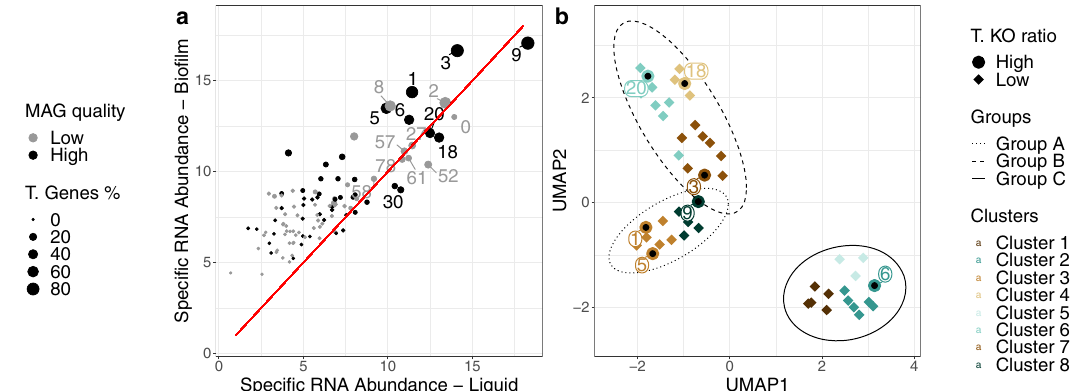
Fig. 1 Relationship of MAGs in bio fi lm and liquid according to speci fi c RNA abundance and their functional grouping. a Relationship between speci fi c RNA abundance in bio fi lm and liquid for all MAGs. The black-coloured points indicate high-quality MAGs which were used for further analysis. The relative placement of the points with the red diagonal line reveals in which phase the speci fi c RNA abundance is higher. The size re fl ects the percentage of identi fi ed genes with mapped mRNA. Note that MAG 9 occupies the highest speci fi c RNA abundance in both phases followed by MAG 3. MAGs 1, 2, 5, 6, 8, 18 and 20 have a medium level of speci fi c RNA abundance. b Functional landscape of the selected MAGs. The colours of the points indicate 8 functional clusters of MAGs, while the ellipses further gather them into three groups. The shape of the points indicates the ratio of the transcribed (T.) KOs (KEGG Orthologs) where the circular points are from the dominant members of the community (as de fi ned in the text) and the rhombus points are from the non- dominant members of the community. The numbers next to the circular points indicate the dominant MAGs. For the dimensional reduction and clustering, we used Uniform Manifold Approximation and Projection (UMAP) and af fi nity propagation, respectively, on the binary (presence/absence) KO matrix. Note that the dominant MAGs are distributed across the functional